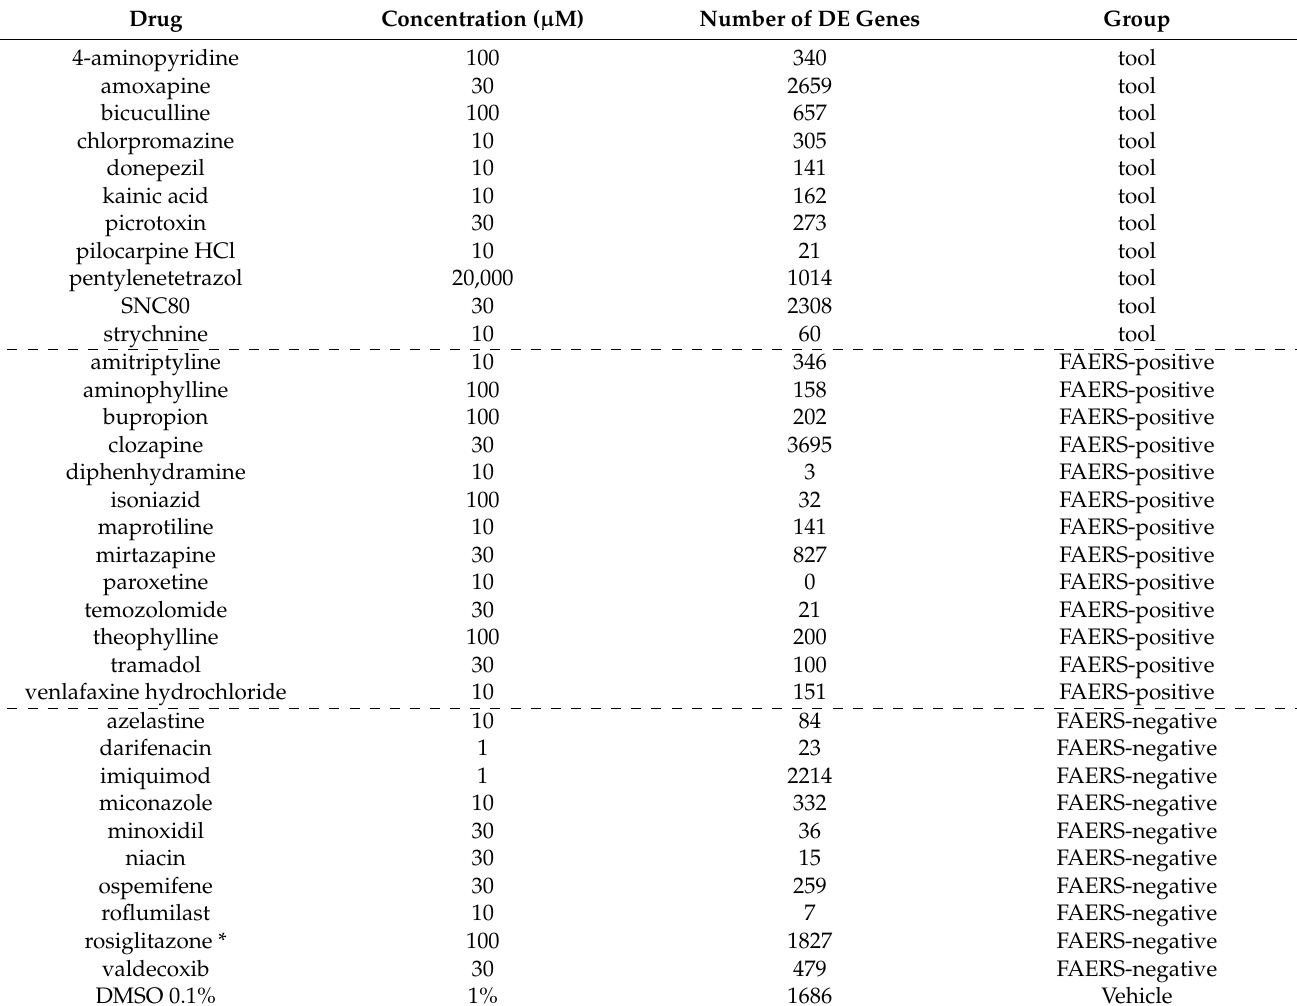
Table 2. Number of differentially expressed